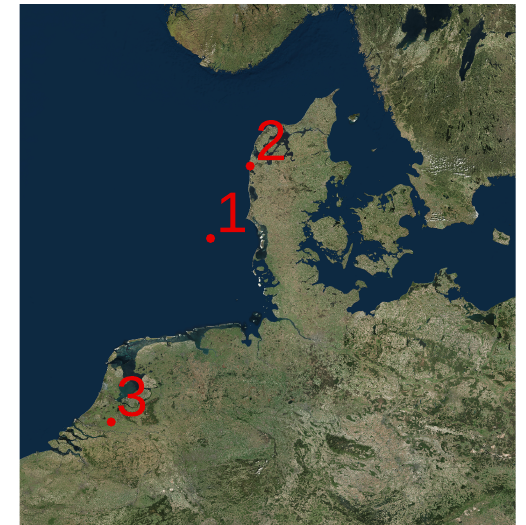
Figure 1. Map of northern Europe with the three site locations used in the model intercomparison: (1) FINO3, in the North